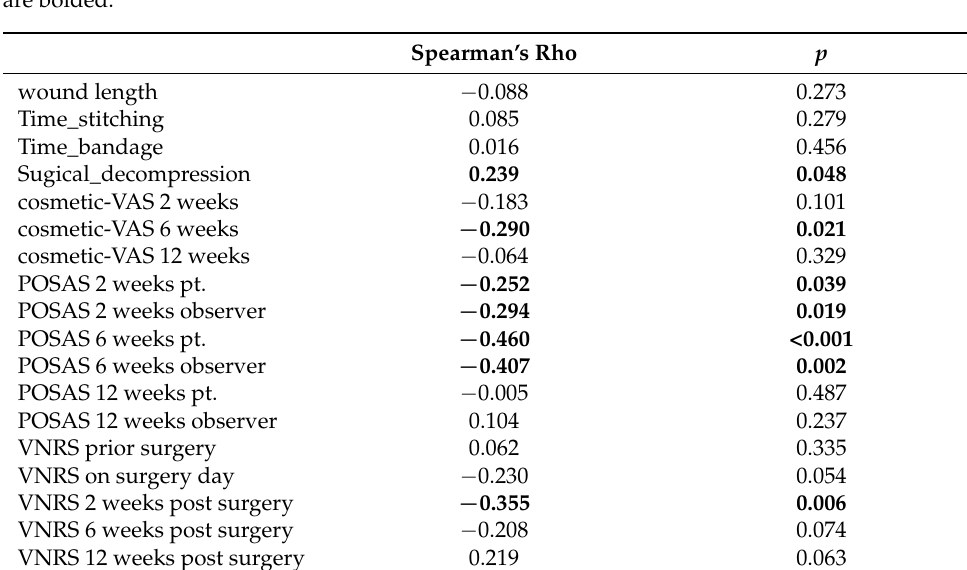
Figure 4. POSAS scores evaluated by the patient during the follow-up period after surgery.